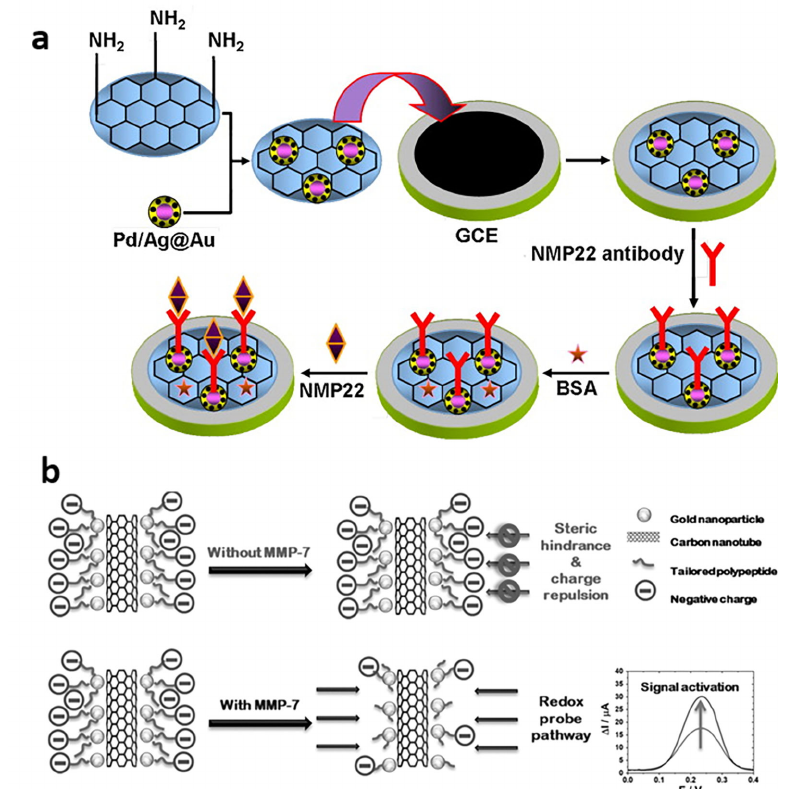
Figure 3. Schematic of the label-free electrochemical sensor. ( a ) The fabrication of the Au@Pd/Ag /NH 2 -GS electrochemical immunosensor. (Reprinted with permission Ref. [38]. Copyright © 2014